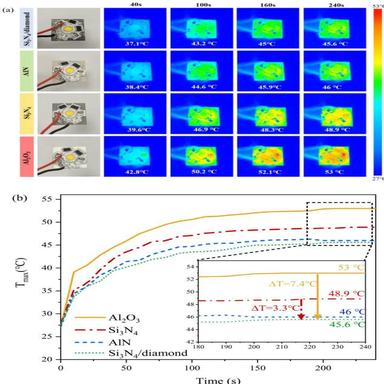
Heat dissipation efficiency of different materials: (a) infrared images and (b) working temperatures, respectively, of LED chips with different heat dissipation materials.